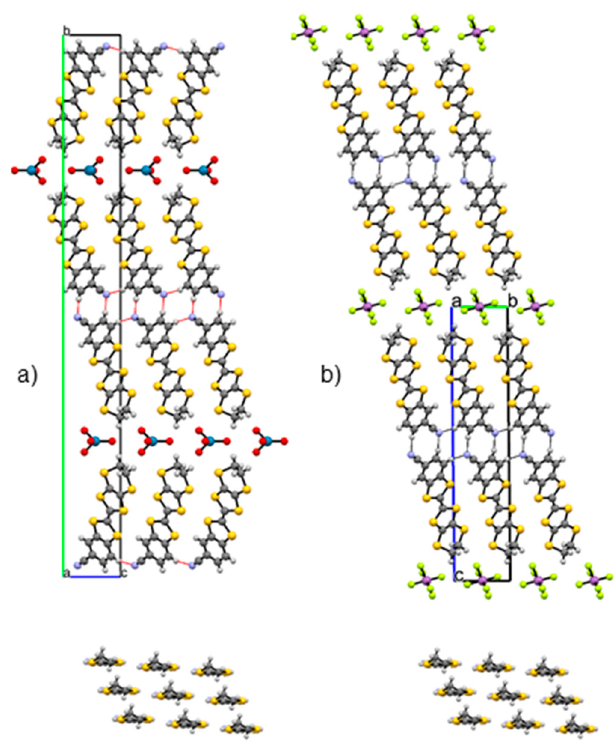
Figure 2. Crystal structure of monoclinic (CNB-EDT-TTF) 4 ReO 4 , ( a ) and triclinic (CNB-EDT-TTF) 4 SbF 6 , ( b ). Top, views of the crystal structures along the crystallographic axis a , (anion positions depicted have 0.5 occupation factor) the thin lines (pink on ( a ) and blue in ( b )) denote the C-N ... H interactions. Bottom, partial view of one donor layer along the donor long axis, illustrating the β ”-type packing pattern. Atoms color scheme: grey (C); yellow (S); lime (F); medium slate blue (N); dodger blue (Re); red (O); blue violet (Sb); white (H).